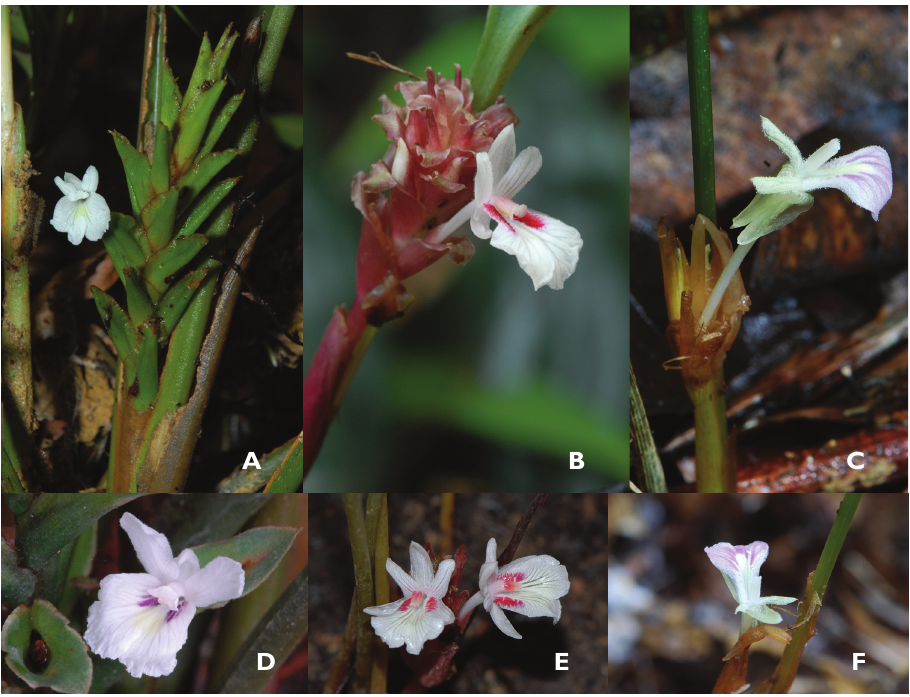
Figure 5. A–C Floral bracts A Green and coriaceous in Scaphochlamys klossii B Red and coriaceous in Scaphochlamys pusilla C Scarious and marcescent in Borneocola petiolatus D–F Variegation on labellum D White labellum with purple lines beside the median band in Scaphochlamys malaccana E White label- lum with red streaks beside the band in Scaphochlamys concinna F Lilac labellum without coloured streaks beside the band in Borneocola petiolatus . (Photographs by Y.Y. Sam)